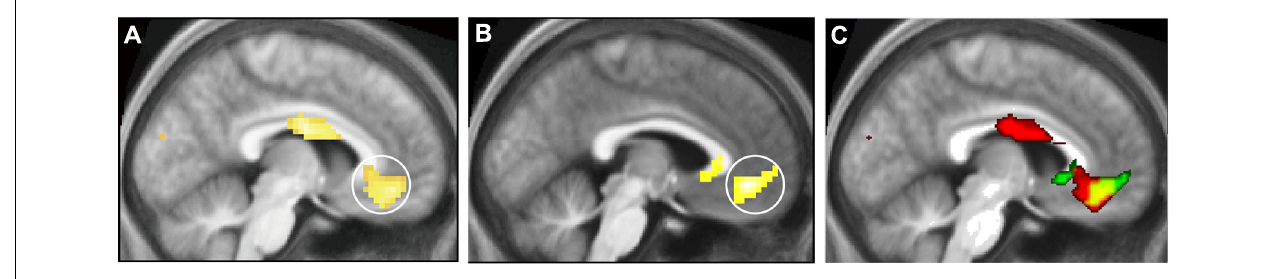
FIGURE 1 | Cortical activation correlating with the experience of beauty. Brain activity obtained through (A) the contrast Visually Beautiful > Visually Ugly , (B) the contrast Musically Beautiful > Musically Ugly . Panel (C) shows the results of a conjunction analysis to reveal the